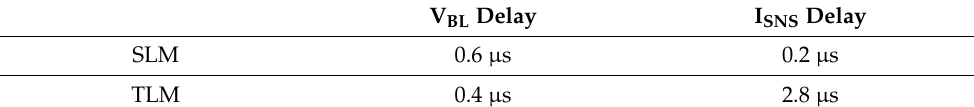
Table 3. Tpre window in the case that “a delay that is 20% longer than the minimum” is acceptable.